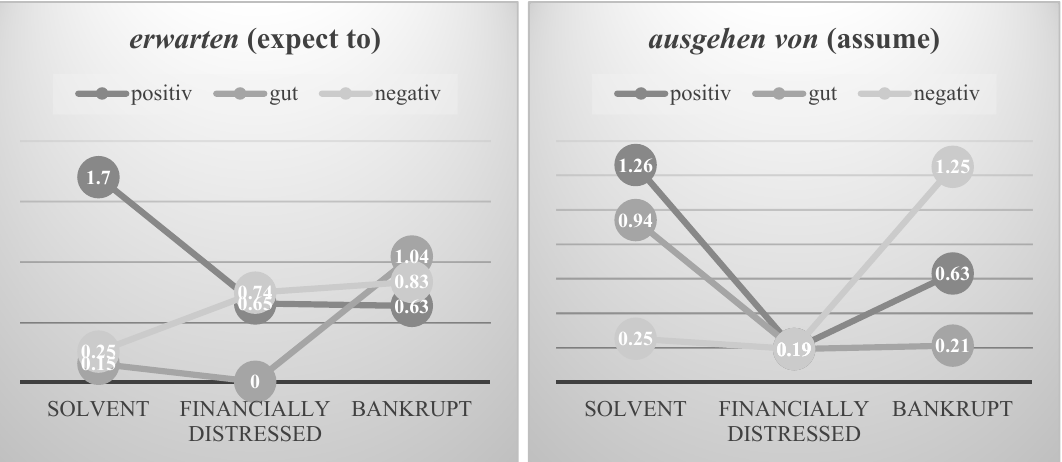
Figure 2. Distribution of evaluative adjectives following evidential strategies in financial statements.